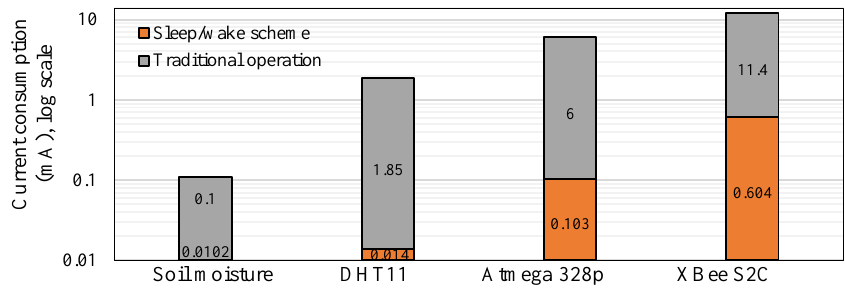
Figure 11. Current consumption of each sensor node component with and without the sleep/wake scheme.